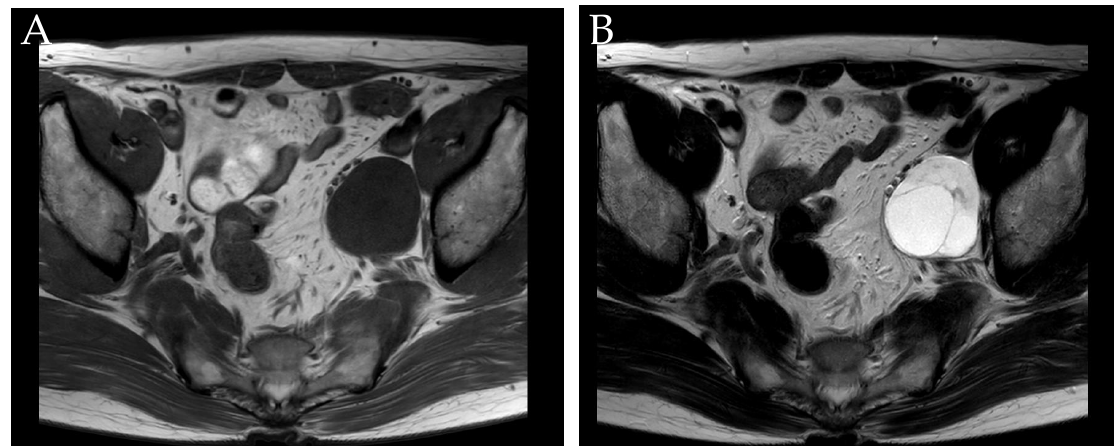
Figure 1. ( A ) A T1-weighted magnetic resonance image shows a homogenous low-signal-intensity mass, while ( B ) the T2-weighted MR image reveals several cysts with septa within the tumor.